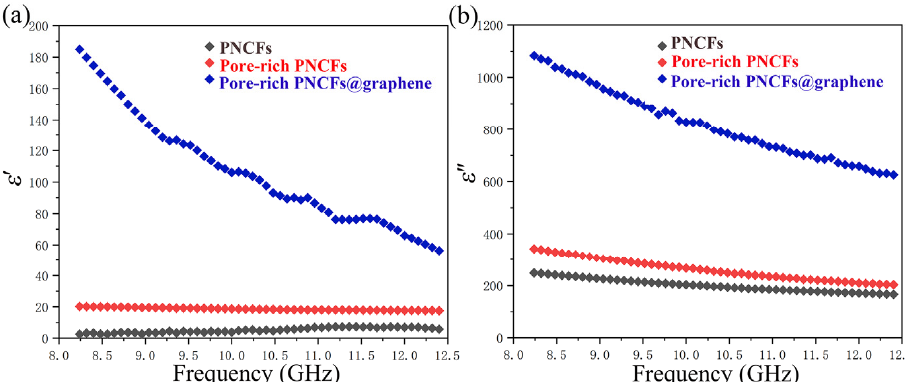
Figure 8. Complex permittivity of the PNCFs, pore-rich PNCFs, and pore-rich PNCFs@graphene. ( a ) Real part; ( b ) imaginary